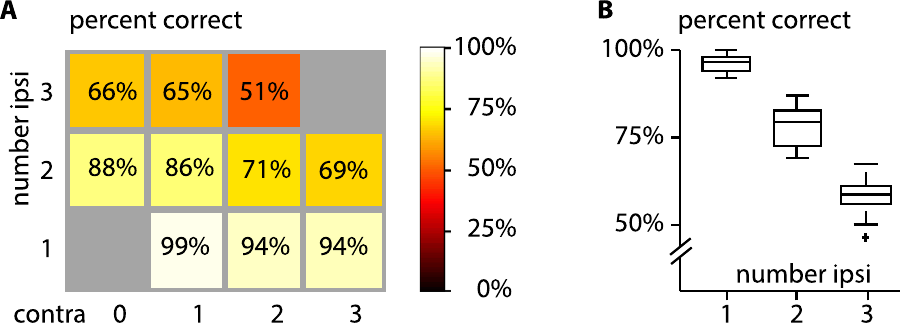
Figure 4. Capacity of working memory is independent between the two hemispheres. (A) Performance of both animals as a function of number of stimuli on target side (number ipsi) and number of items contralateral to the target (contra). Background shading indicates mean percent correct on all attempted trials. (B) Performance of both animals as a function of items on the target side ( mean, 1: 96%, 2: 78%, 3: 58%). Box-plots display median, 25 th and 75 th percentile, whiskers display the full extent of the data, crosses indicate